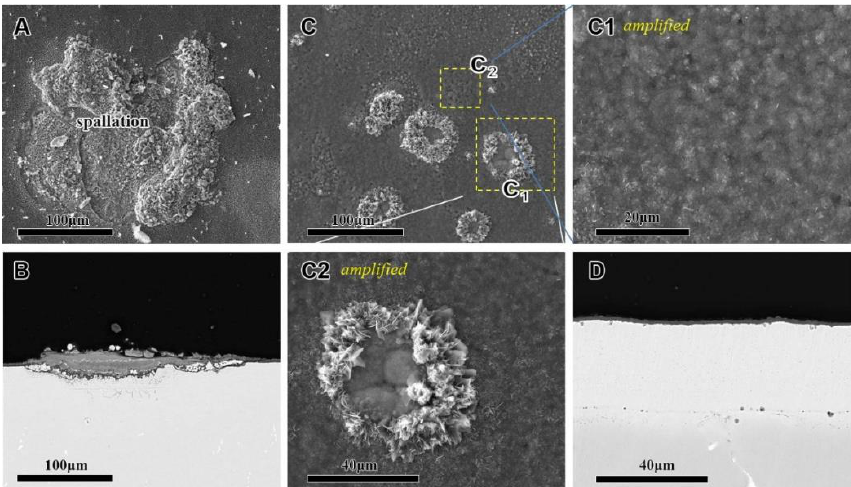
Figure 6. Microstructures of nanocrystalline coatings after oxidation at 1050 °C for 200 h: ( A ) surface and ( B ) cross-sectional morphologies of SN-K38 coating; ( C ) surface (amplified view in C and denoted as C 1 and C 2 ) and ( D ) cross-section morphologies of SN-K5 coating.